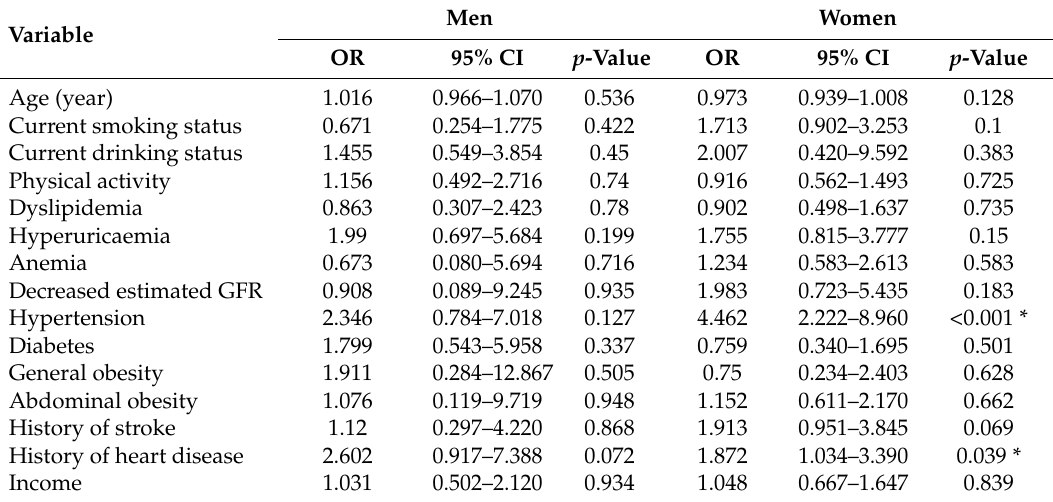
Table 2. Results of multivariable regression analyses of potential risk factors for heart failure with preserved ejection